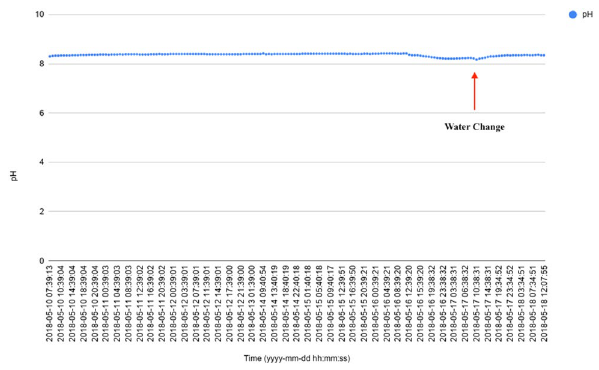
Fig. 15 Salinity data from multi-sensor node while monitoring the Kob